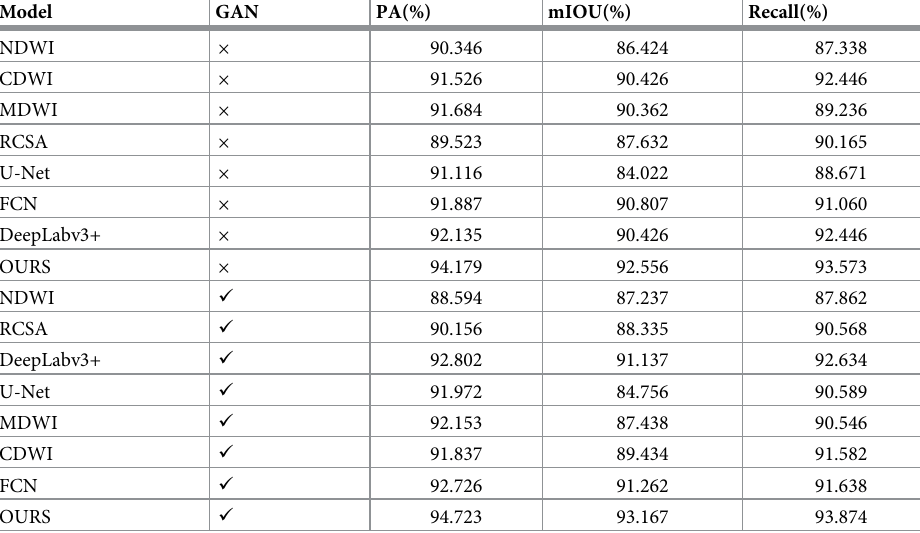
Table 3. Comparison of models.